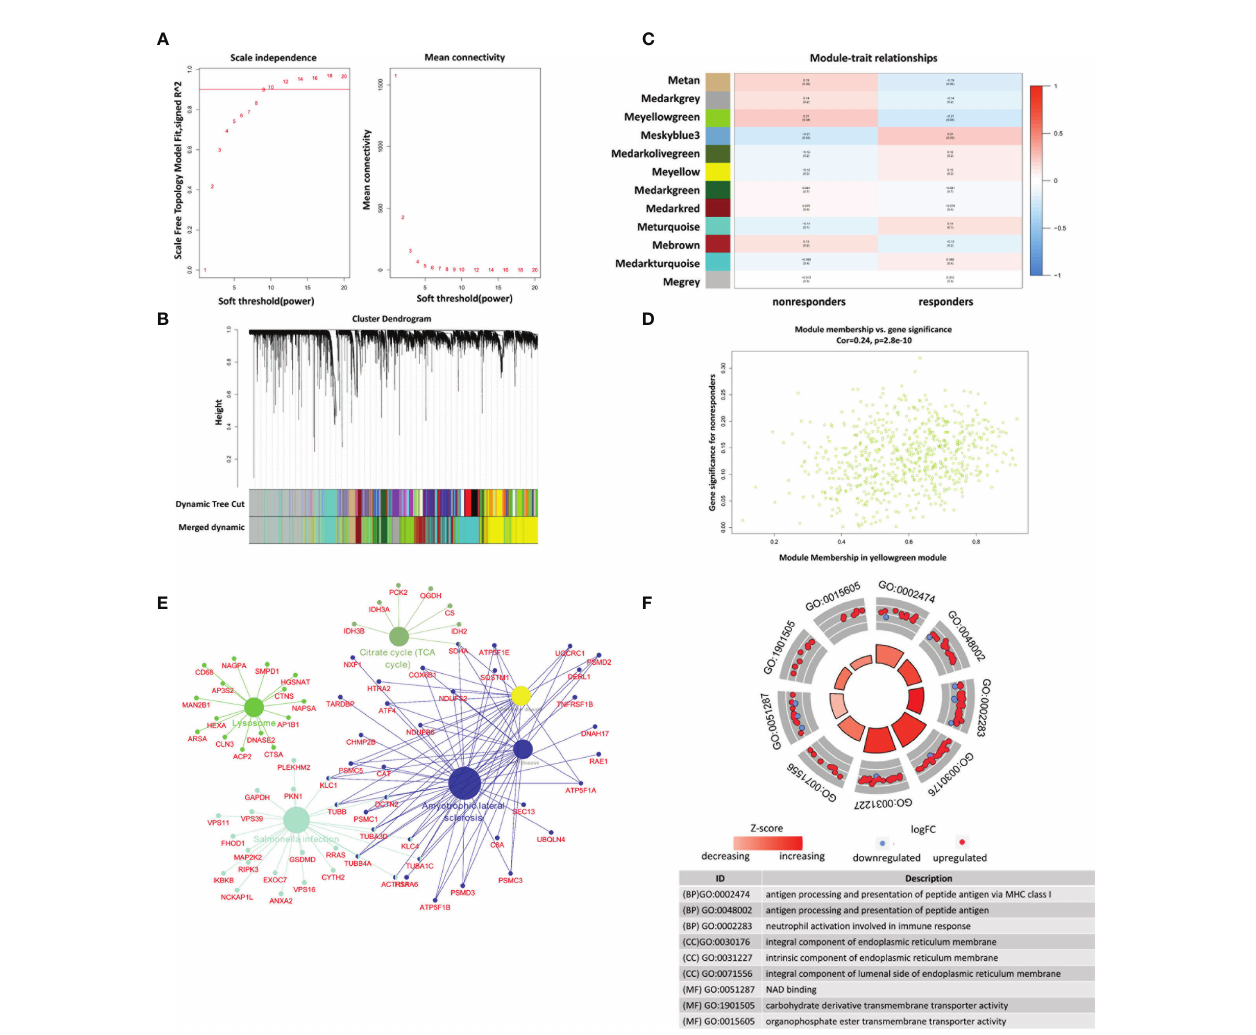
FIGURE 4 | Identi fi cation of modules associated with nonresponse to IFX treatment in RA in GSE78068 dataset through weighted gene coexpression network analysis (WGCNA). (A) Correlation between scale free topology model fi t and soft threshold power. (B) The cluster dendrogram showing the change of modules before and after merging, and different colors represent different modules. (C) Module-trait relationships. Each row represents a module and each column represents a clinical trait (responders and nonresponders). (D) Scatter plot of genes in the yellow-green module. (E) The network of KEGG pathway in the yellow-green module. (F) The GO analysis of the genes in yellow-green